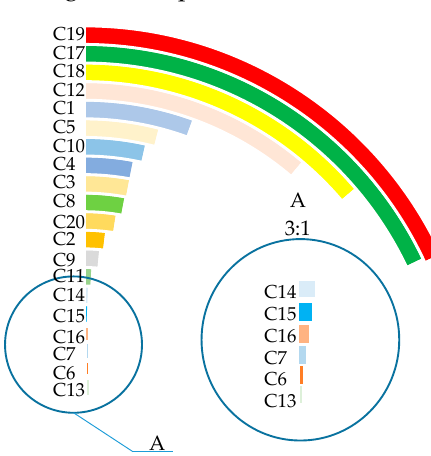
Figure 6. Radial bar chart of IIM.